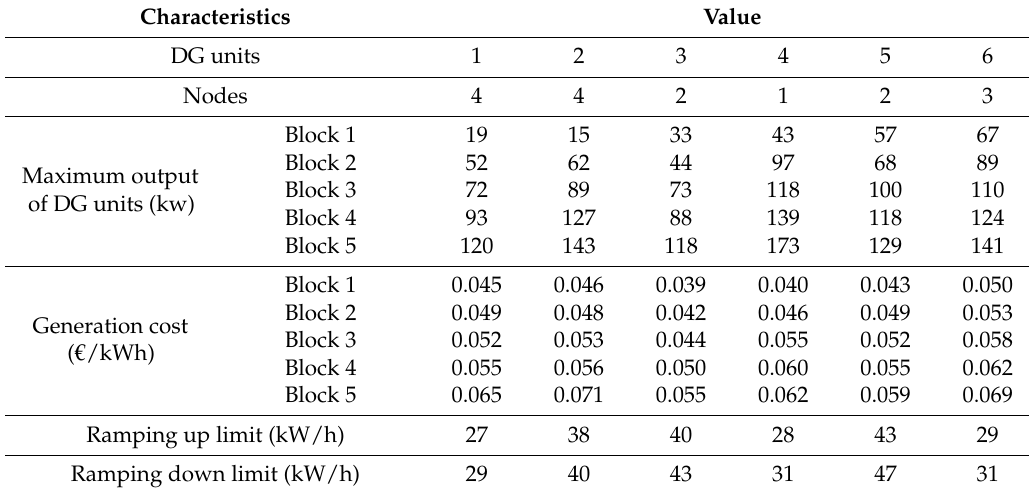
Table 3. Characteristics of the DG units.